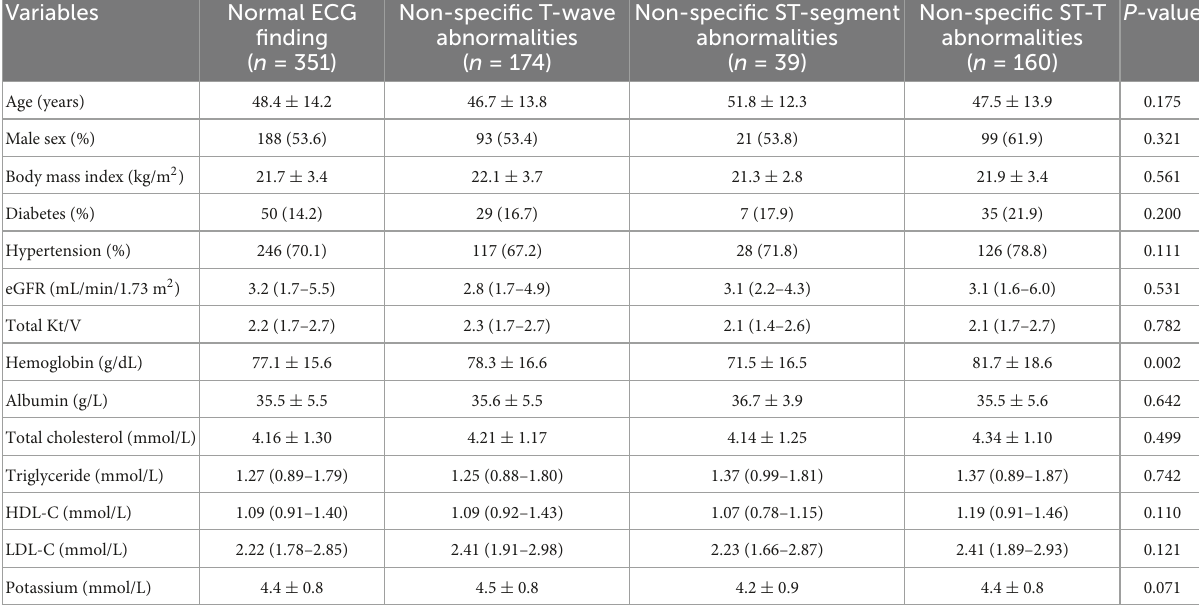
TABLE 1 Baseline characteristics of participants with or without non-specific ST-segment and/or T-wave abnormalities.